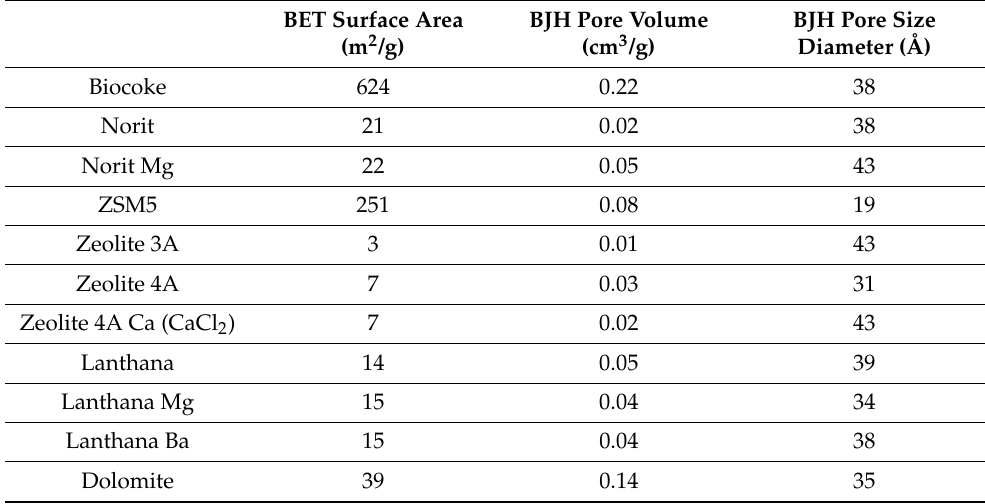
Table 2. Surface characterization of pure and modified calcined sorbents by N 2 adsorption– desorption isotherms: BET surface area, BJH cumulative desorption pore volume and BJH desorption pore